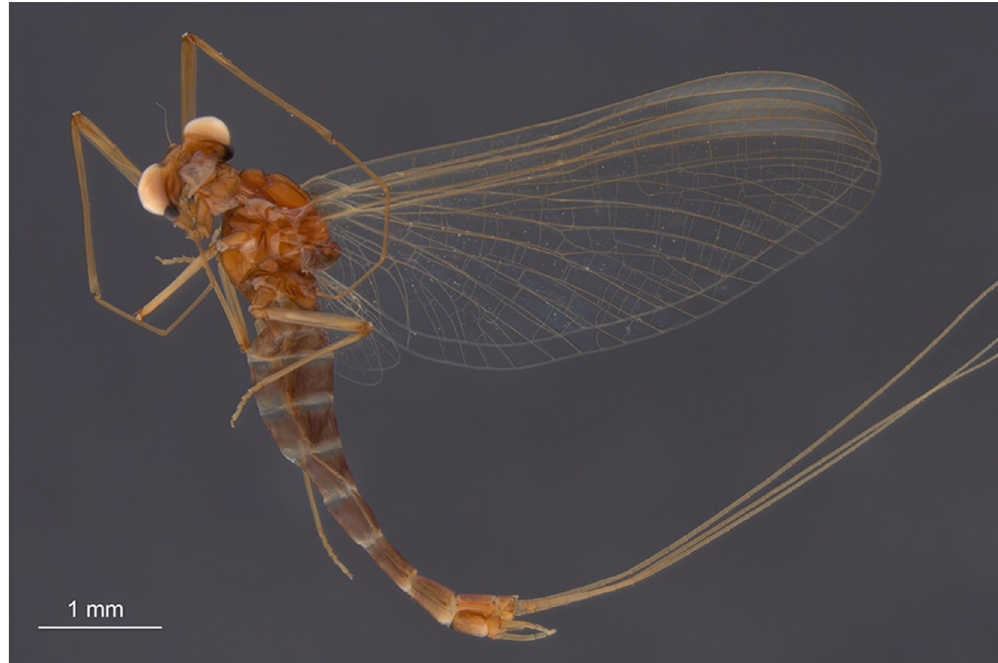
Figure 9. Calliarcys humilis Eaton, 1881, male imago [Spain; Sartori M. coll.].